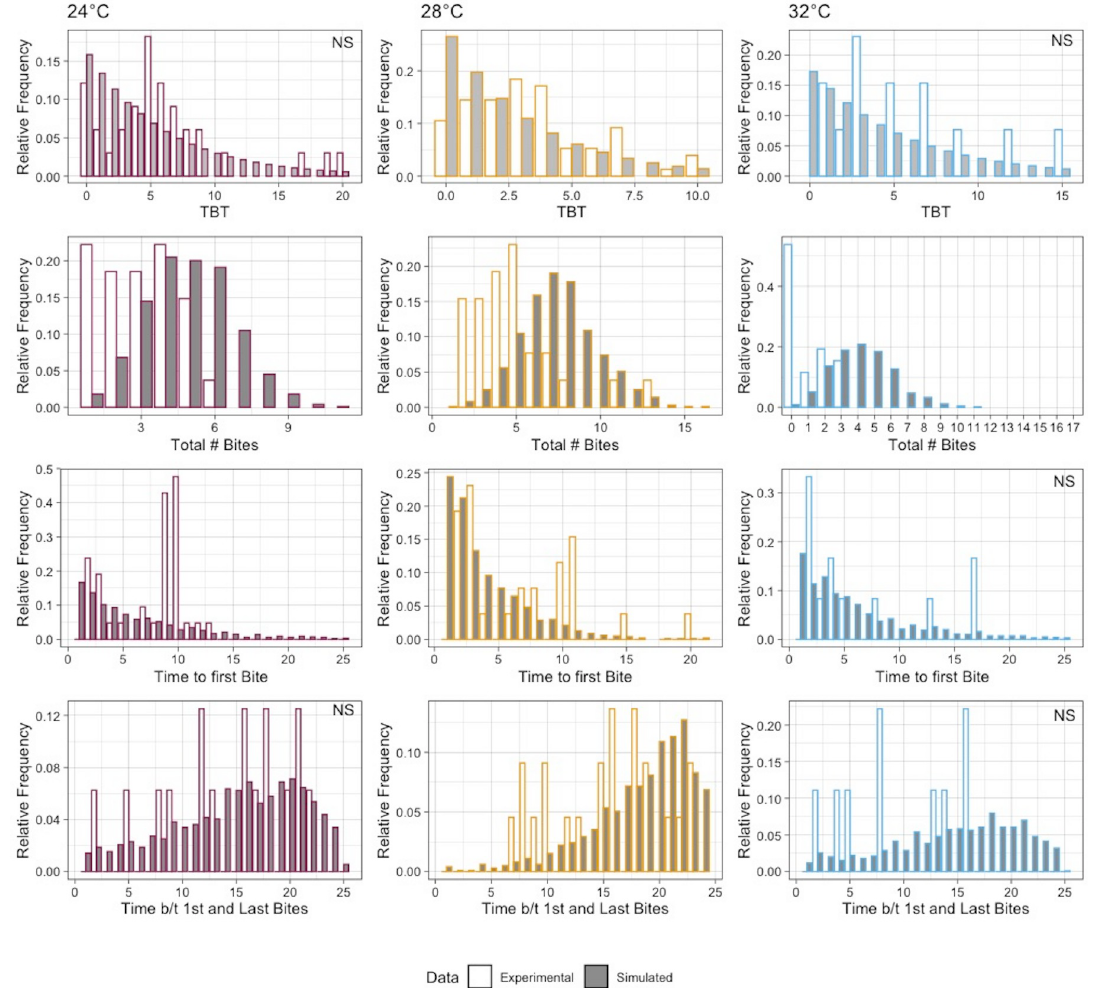
Fig 5. Distributions of metrics describing biting from the experimental data (white bars) to data simulated under the null assumptions of ~EXP( λ Temp ) (grey bars). Top Row: Time between bites. Second Row: the total number of bites. Third Row: the time to first bite. Bottom Row: Time between first and last bites. Distribution differences were tested usng the Chi–square goodness of fit and NS indicates not significant.